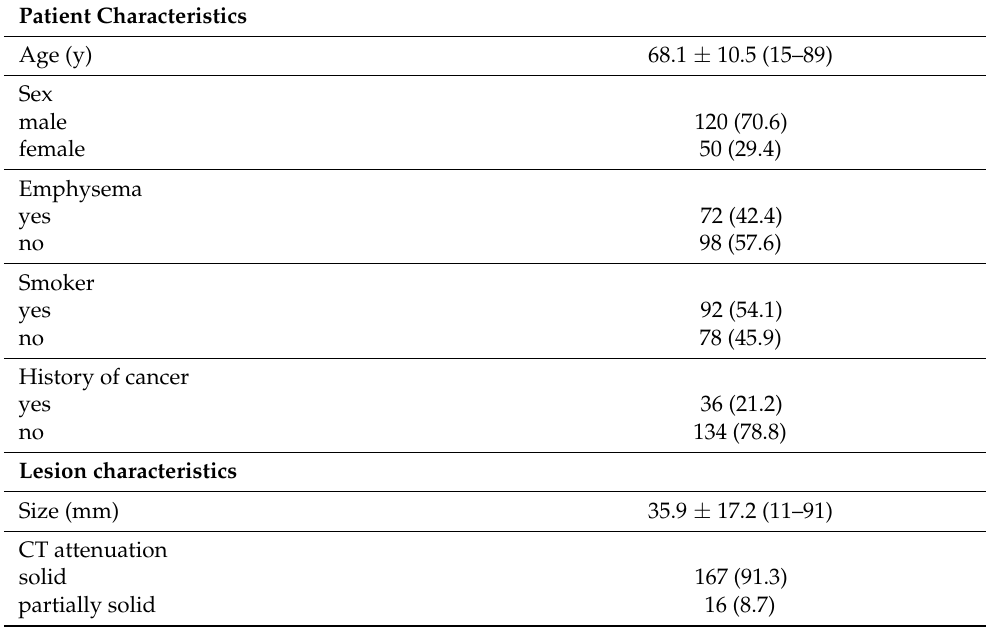
Table 1. Characteristics of patients, lesions and biopsy